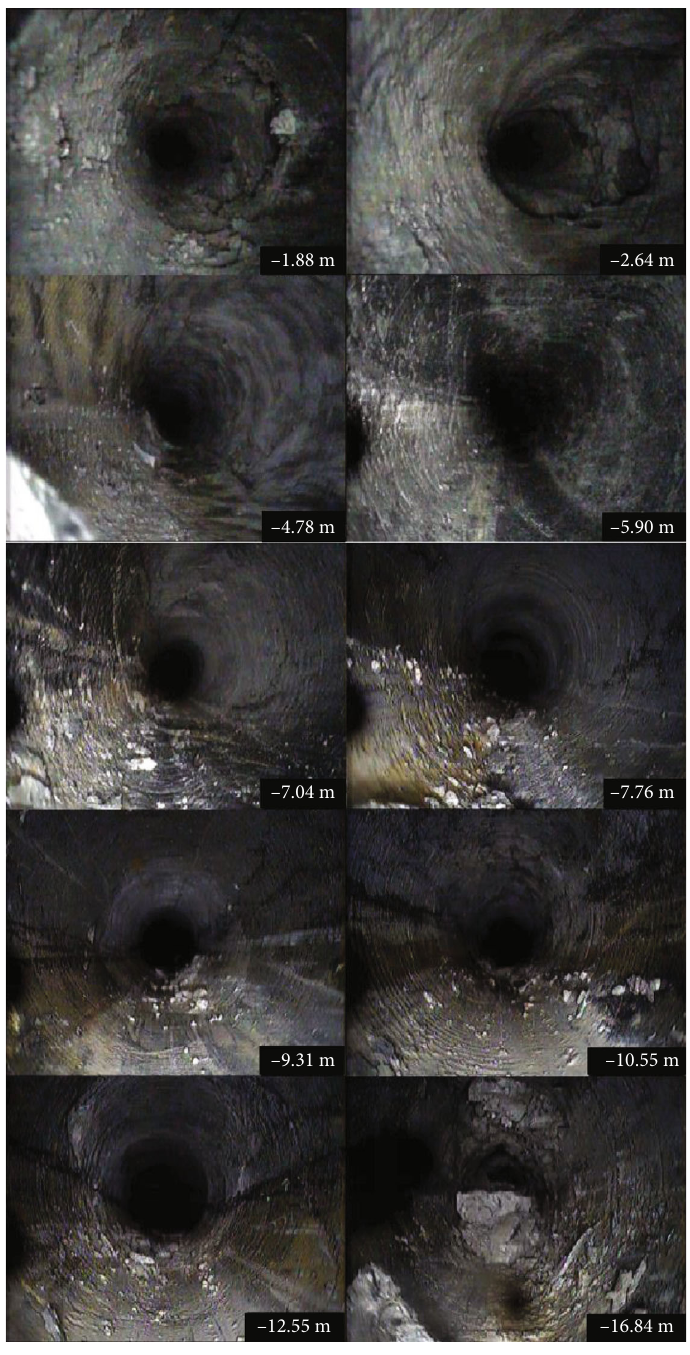
Figure 10: View of high-level borehole in C 5b coal